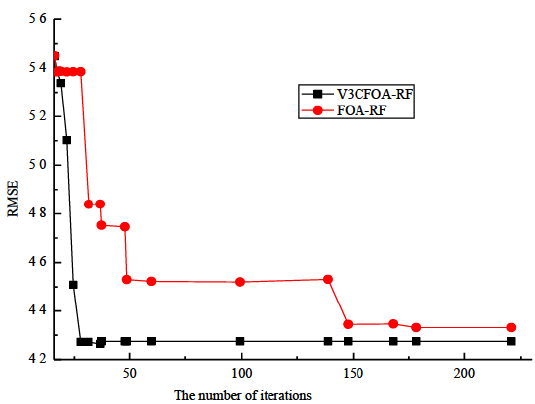
Figure 7: Iterative evolution curve of V3CFOA-RF and FOA-RF